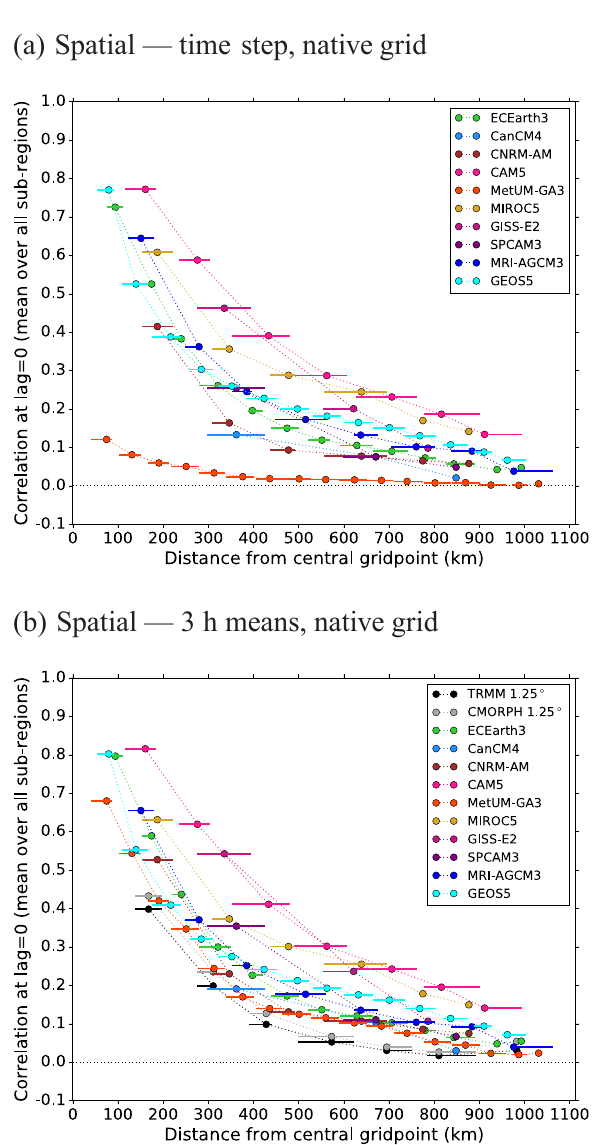
Figure 11. As in Fig. 6a, but for gridpoint precipitation data for (a) the native time step and (b) 3h means. Panel (b) includes the TRMM 3B42 and CMORPH analyses at 1.25 ◦ resolution, for the same temporal period and horizontal domain as the models. Panel (a) is repeated from Fig. 6a for ease of